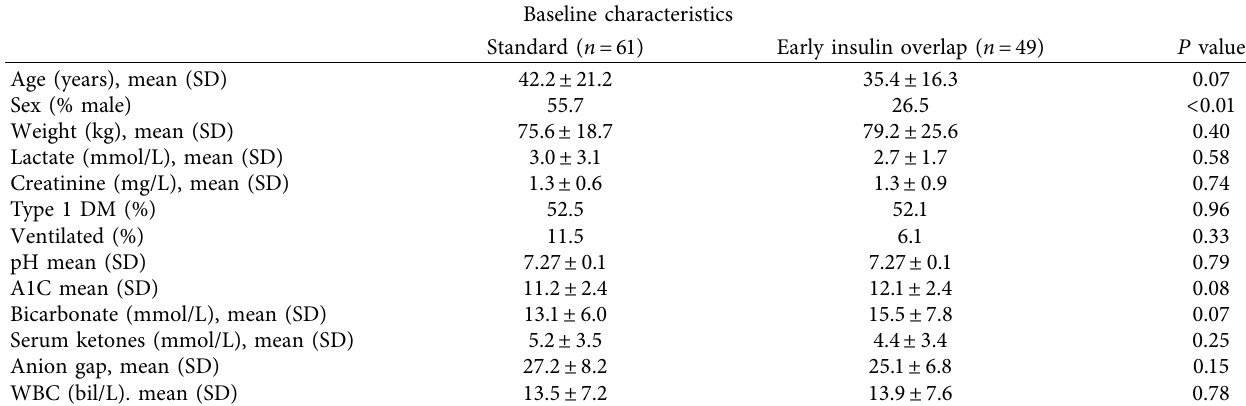
Table 3: Standard overlap vs. early addition of long-acting insulin to